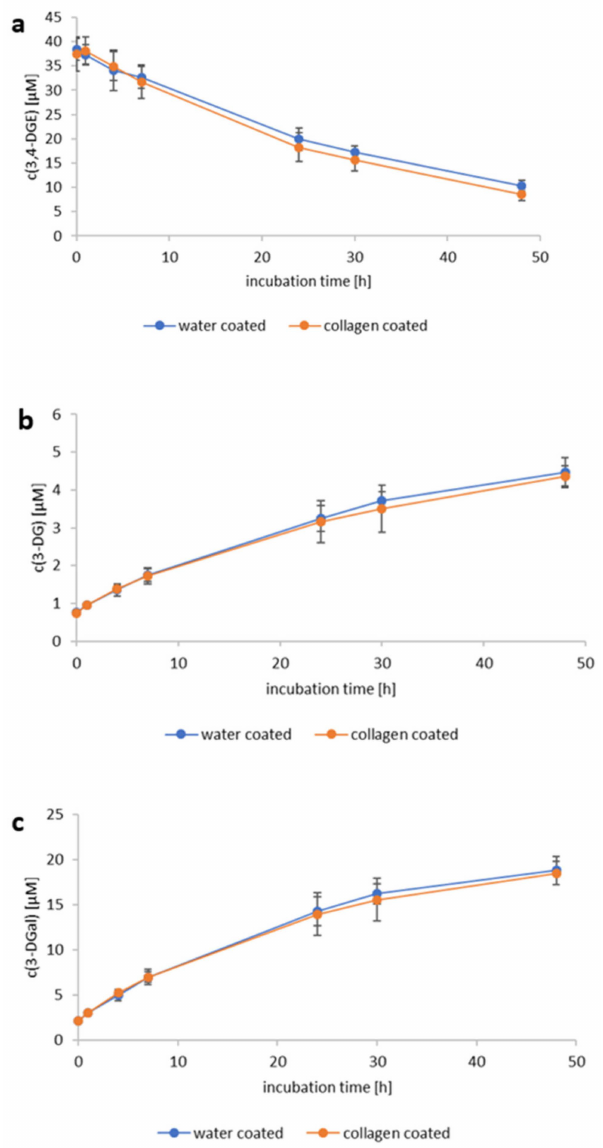
Figure 7. Human placenta-derived collagen does not interact with 3,4-dideoxyglucosone-3-ene (3,4- DGE) and does not affect its interconversion to 3-deoxyglucosone (3-DG) and